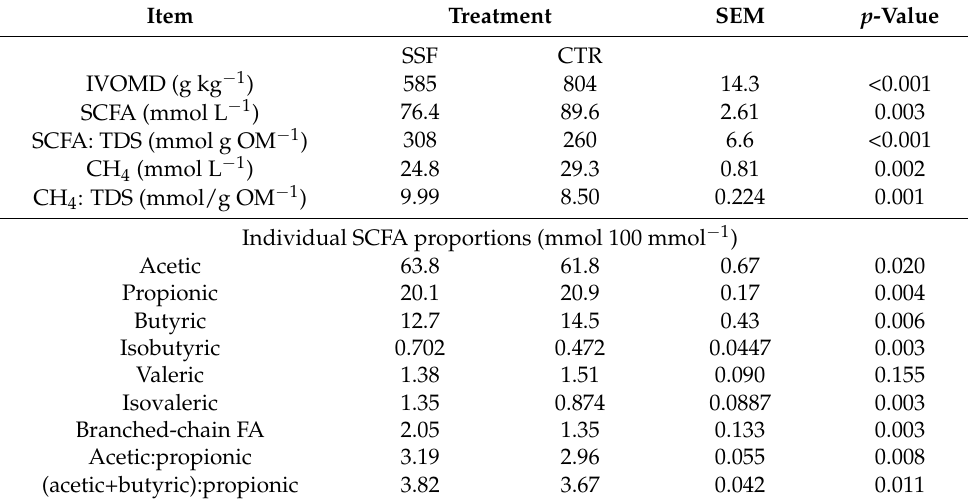
Table 3. Effects of solid state fermentation process on in vitro digestibility and fermentation parame- ters of fruit and vegetable mix